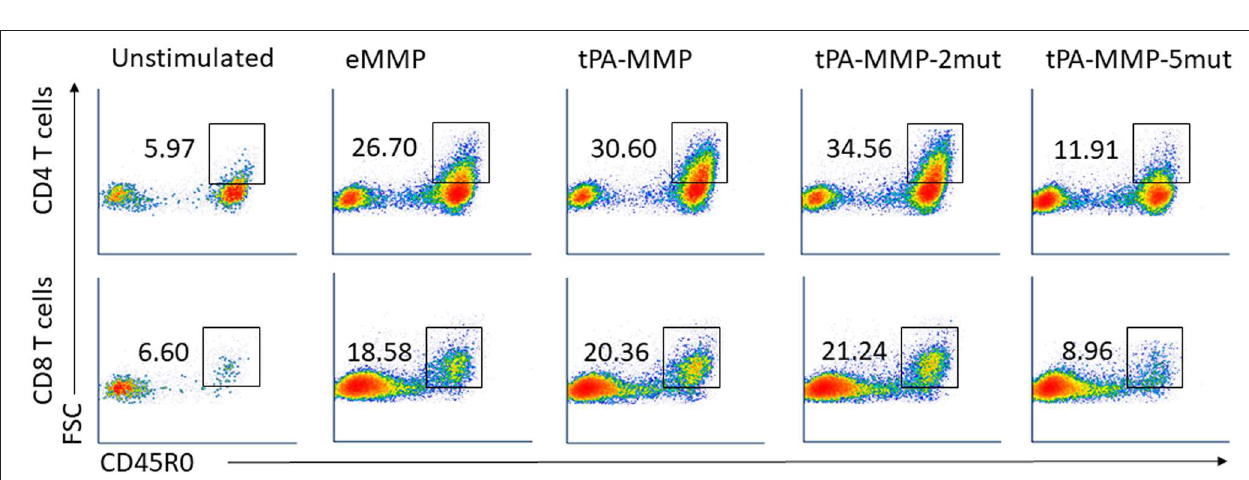
FIGURE 6 | Representative FC profiles comparing CD4 and CD8T cell proliferation in response to peptides. FC dot-plots represent the frequency of activated memory CD4 (first row) and CD8 (second row) T cells in unstimulated or eMMP, tPA-MMP, tPA-MMP-2mut, and tPA-MMP-5mut-stimulated mdPBMC. The profiles are representative of replicates of the FC data obtained from the three steers used in the